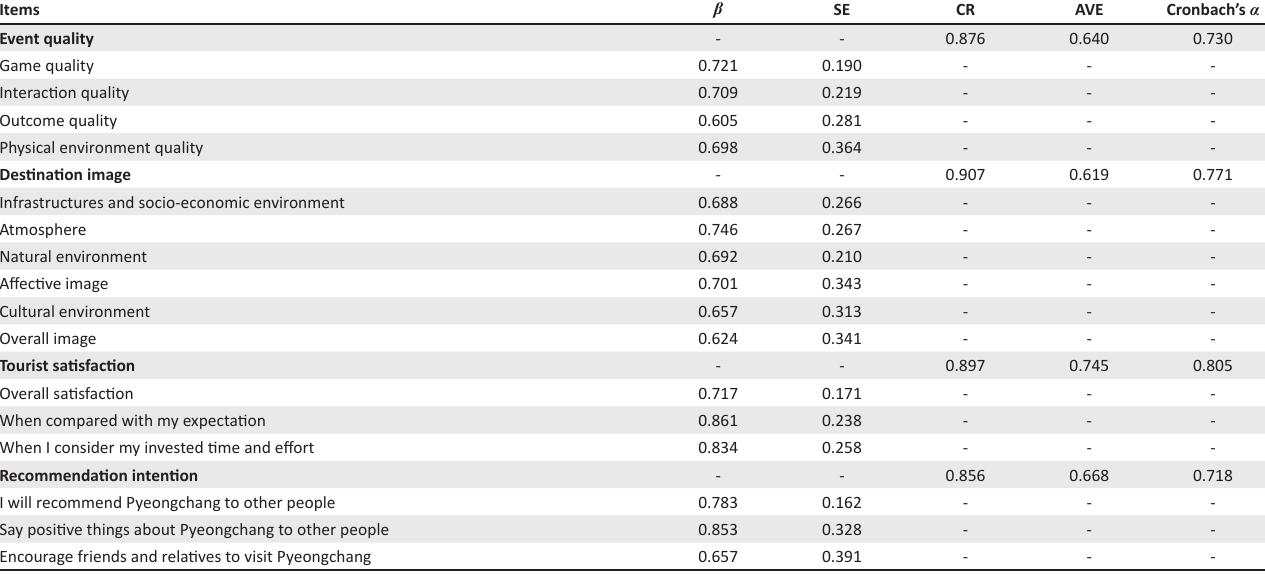
TABLE 2: Confirmatory factor analysis and convergent validity. Items